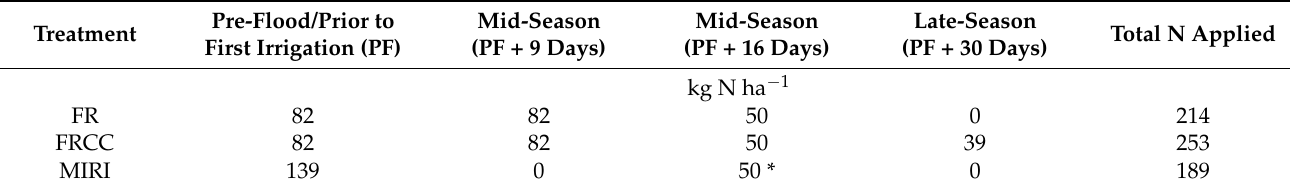
Table 1. Nitrogen (N) application rate under furrow rice (FR), furrow rice with cover crops (FRCC) and multiple inlet rice irrigation (MIRI) system of rice